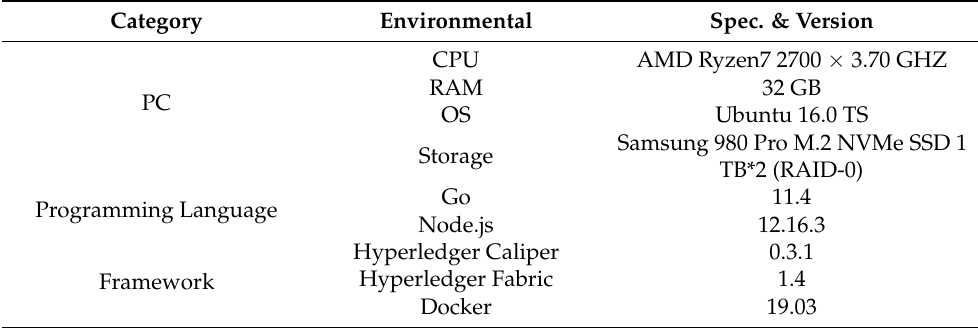
Table 3. Experimental environment.